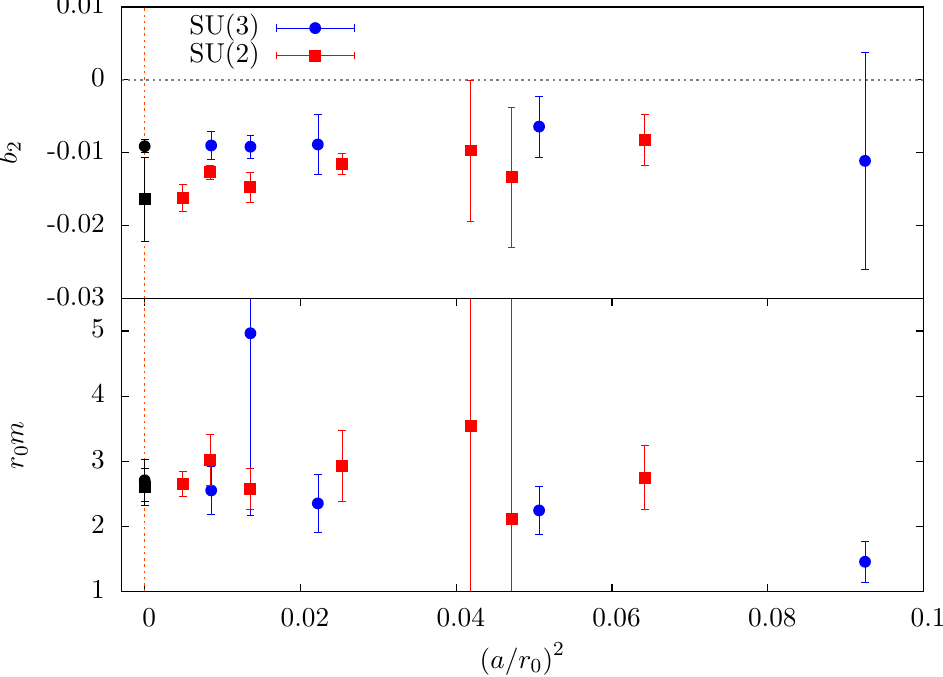
Figure 7 . Results for (cid:22) b 2 and r 0 m versus the squared lattice spacing in units of r 0 . Also shown are the continuum results from eqs. (6.4) and (6.5).